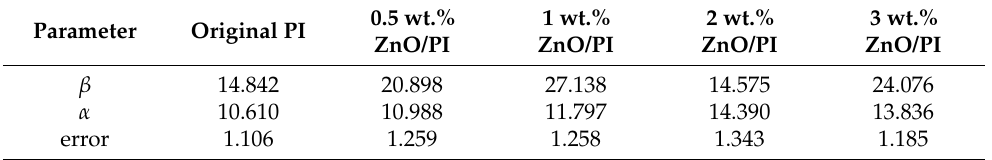
Table 2. Weibull distribution parameters of surface flashover characteristic of ZnO/PI composite films.